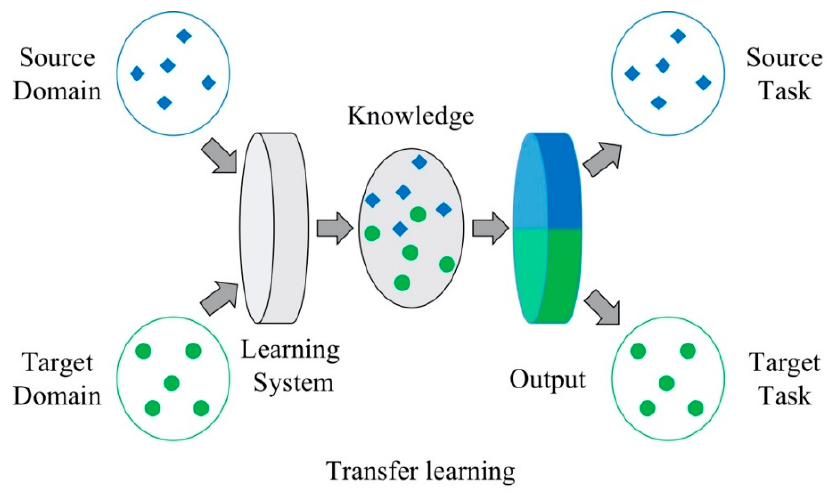
Figure 1. Illustration of transfer learning in model updating.